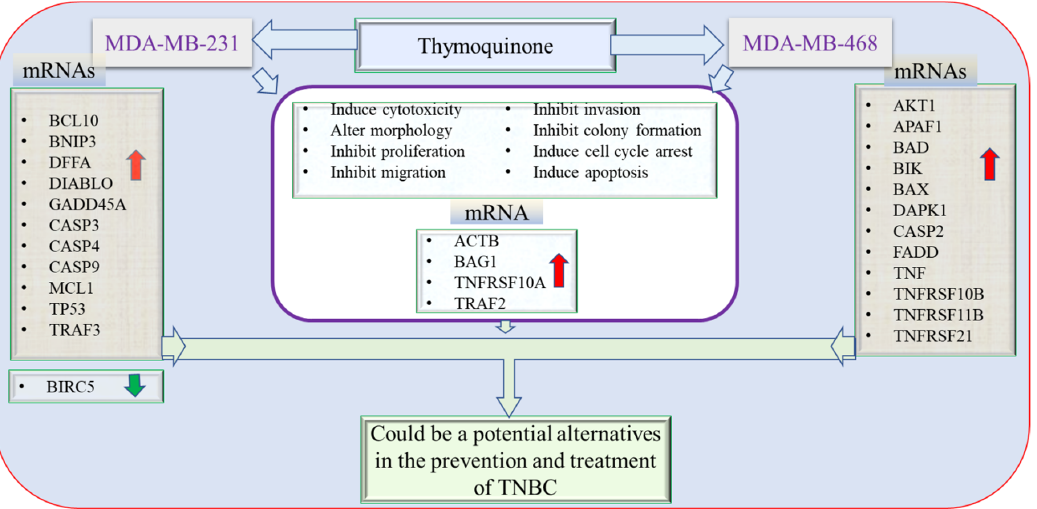
Figure 10. The effect of TQ on apoptotic gene expression in MDA-MB-231 and MDA-MB-468 TNBC cells. TQ inhibits proliferation, invasion, migration, and colony formation, as well as inducing cell cycle arrest and apoptosis. The red arrow indicates that apoptotic genes are being upregulated in both cells, while the green arrow indicates that one gene is being downregulated in MDA-MB-231 cells. Altogether, TQ may end up as a useful agent for the prevention and treatment of